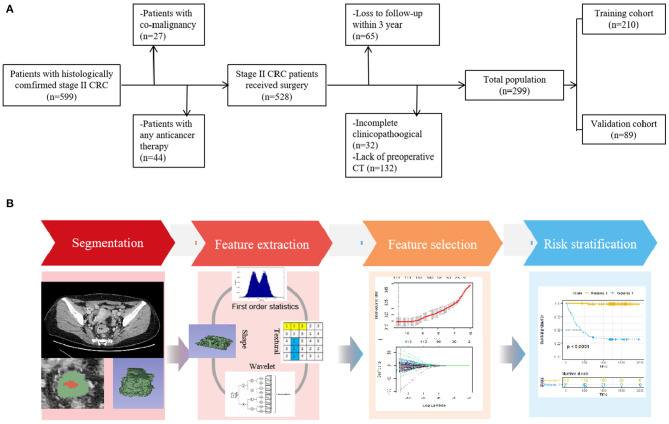
(A) Flowchart of the patient selection process in the present study. (B) Study workflow. The workflow illustrated an overview of the tumor segmentation, feature extraction process, and analysis.